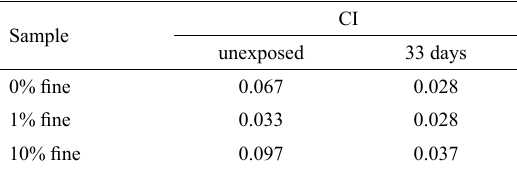
Table 2: Carbonyl index.